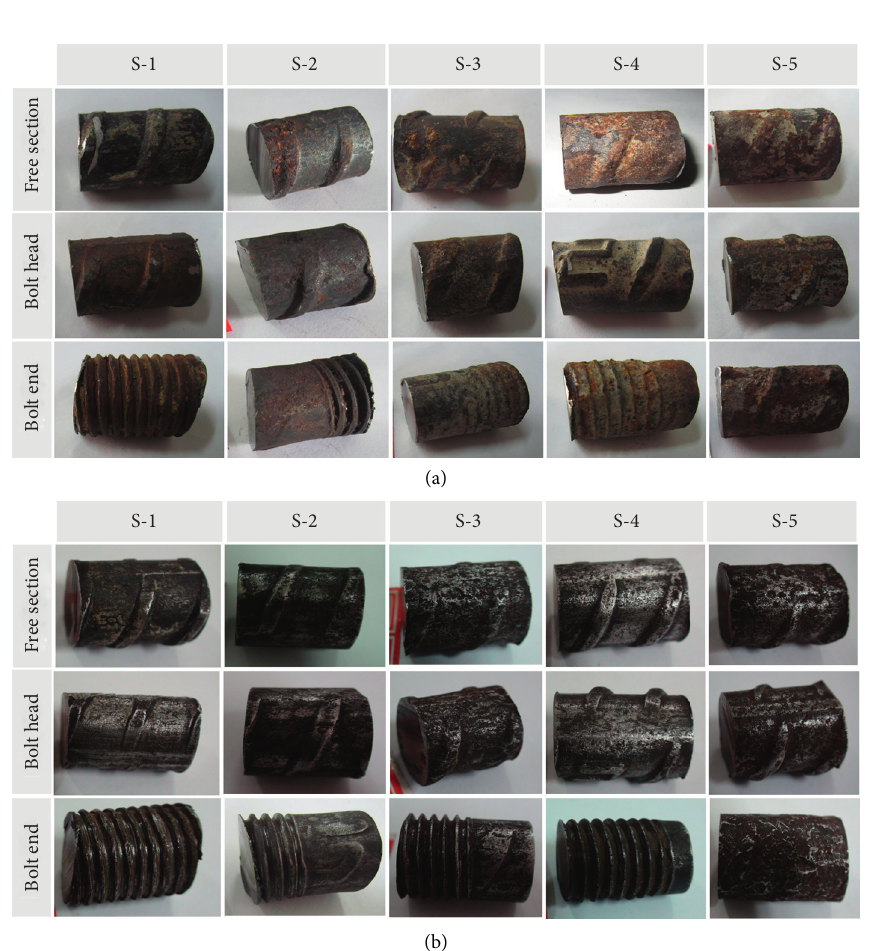
Figure 3: Comparison of the bolt sample (a) before derusting and (b) after